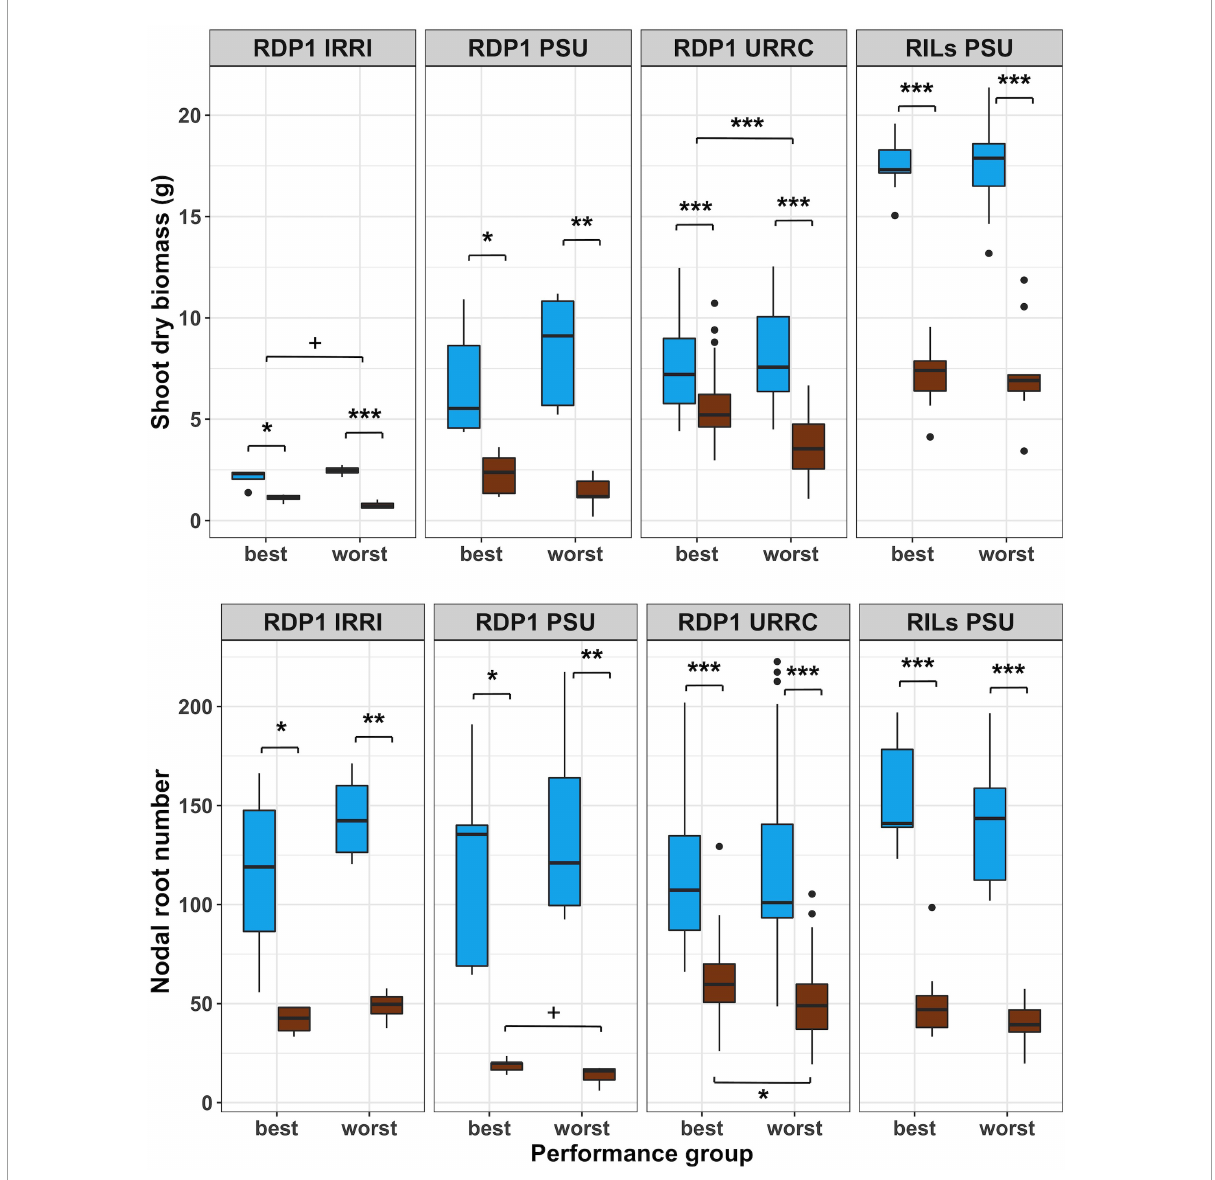
FIGURE2 Boxplots of shoot phenotypes of best and worst groups. Shoot dry biomass and nodal root number under well-watered (blue) and drought (brown) treatments in best and worst performing groups within each experiment location. Genotypes with mean biomass greater than one standard deviation from the mean under well-watered conditions were filtered out, and the remaining genotypes were grouped into best and worst groups based on 50% top and bottom biomass plasticity, respectively. Significance levels ( p -value < 0.1 + , 0.05 ∗ , 0.01 ∗∗ , 0.001 ∗∗∗ ) are shown for t -tests between treatments and performance groups within each